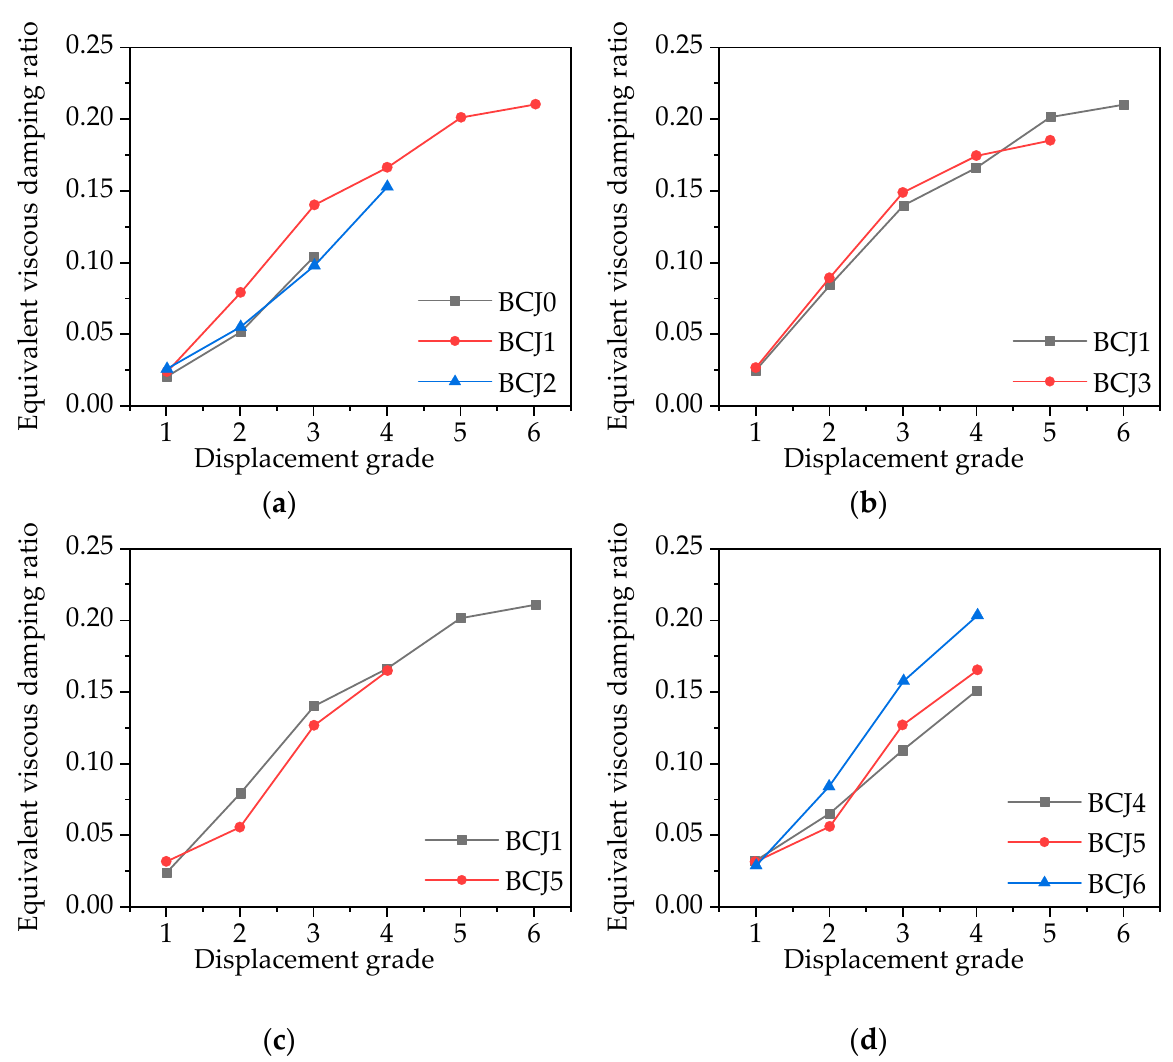
Figure 14. Calculation of the equivalent viscous damping ratio.